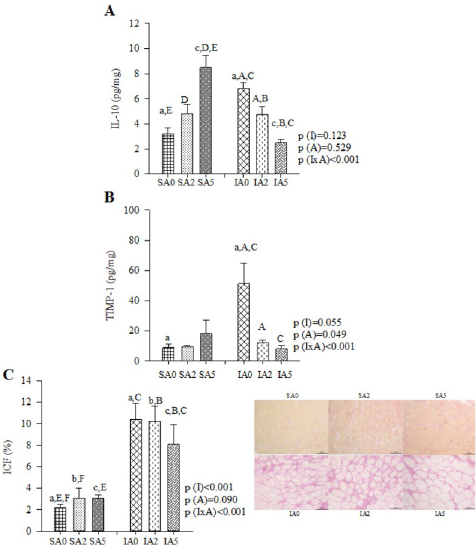
Fig 4. Inflammatory process and collagen deposit in sham and infarcted rats with and without ac¸ai supplementation. (A) IL-10: interleukin 10. Sample size: SA0 = 6; SA2 = 6; SA5 = 6; IA0 = 6; IA2 = 6; IA5 = 6. (B) TIMP-1: tissue inhibitor of metalloproteinase-1. Sample size: SA0 = 6; SA2 = 4; SA5 = 2; IA0 = 4; IA2 = 4; IA5 = 4. (C) ICF: interstitial collagen fraction. Sample size: SA0 = 8; SA2 = 8; SA5 = 8; IA0 = 8; IA2 = 8; IA5 = 8. Data are expressed as mean ± SEM. The same letter represents a significant difference between groups (p <